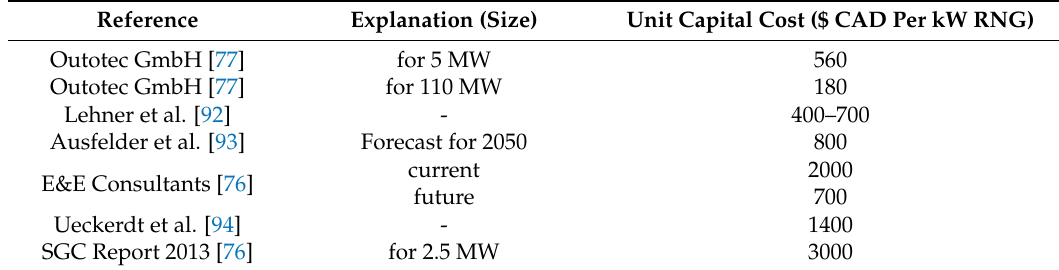
Table 3. Costs of methanation processes.